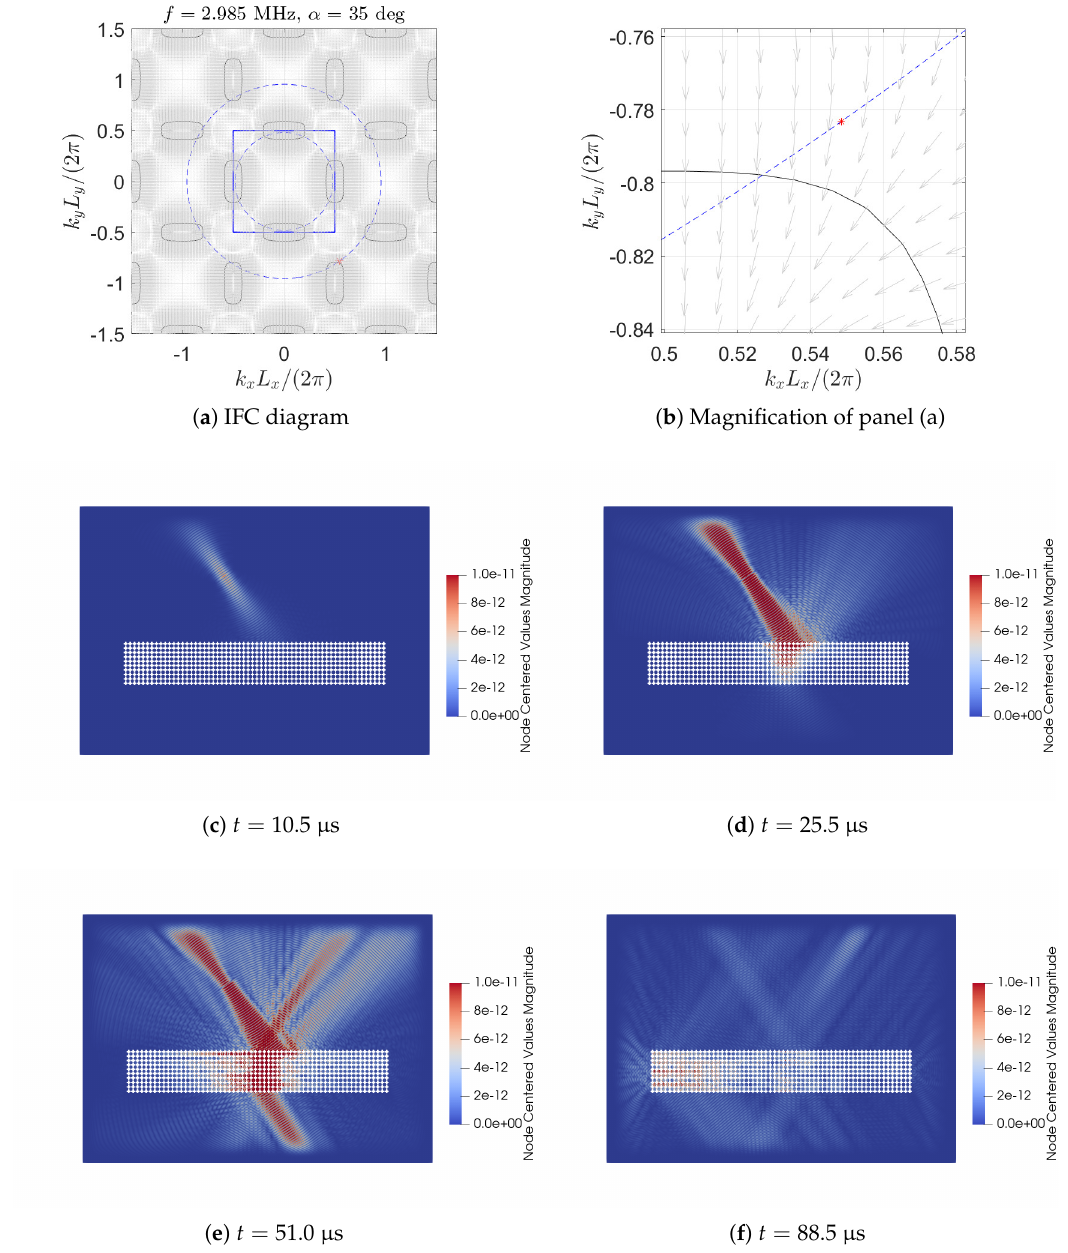
Figure 5. Scattering of a shear-dominated Gaussian beam at centre frequency f = 2.985 MHz and an angle of incidence α = 35 ◦ . Panels ( a , b ) show the IFC diagram (and its magnification); the red asterisk represents the intersection point of the Gaussian beam propagation direction and the isofrequency contours. Panels ( c – f ) show the magnitude of the displacement field at different times in the FE simulation, with the total time being T = 120 µ